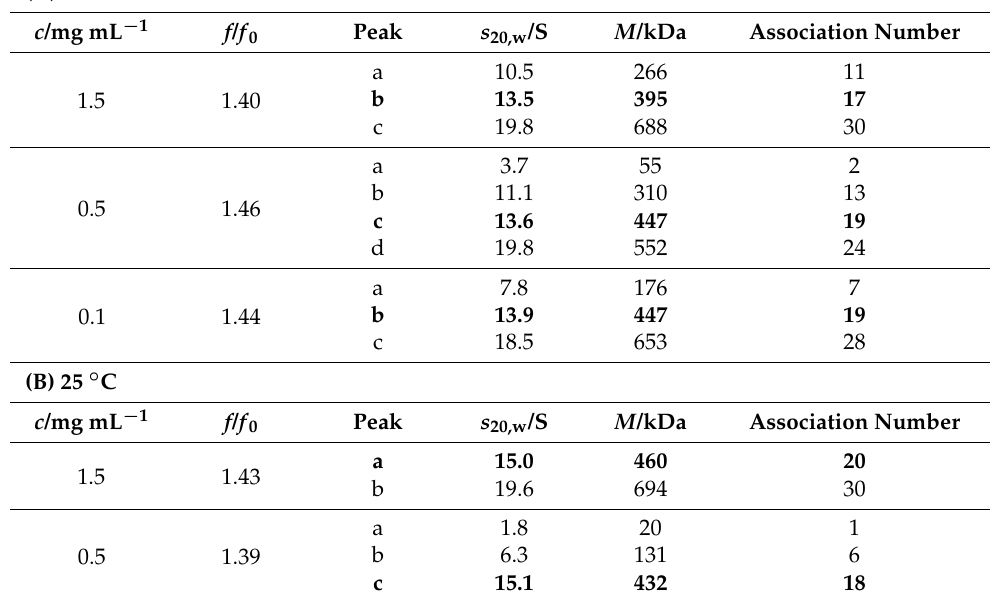
Table 1. Parameters of peak positions of c ( s 20,w ) in Figure 1.